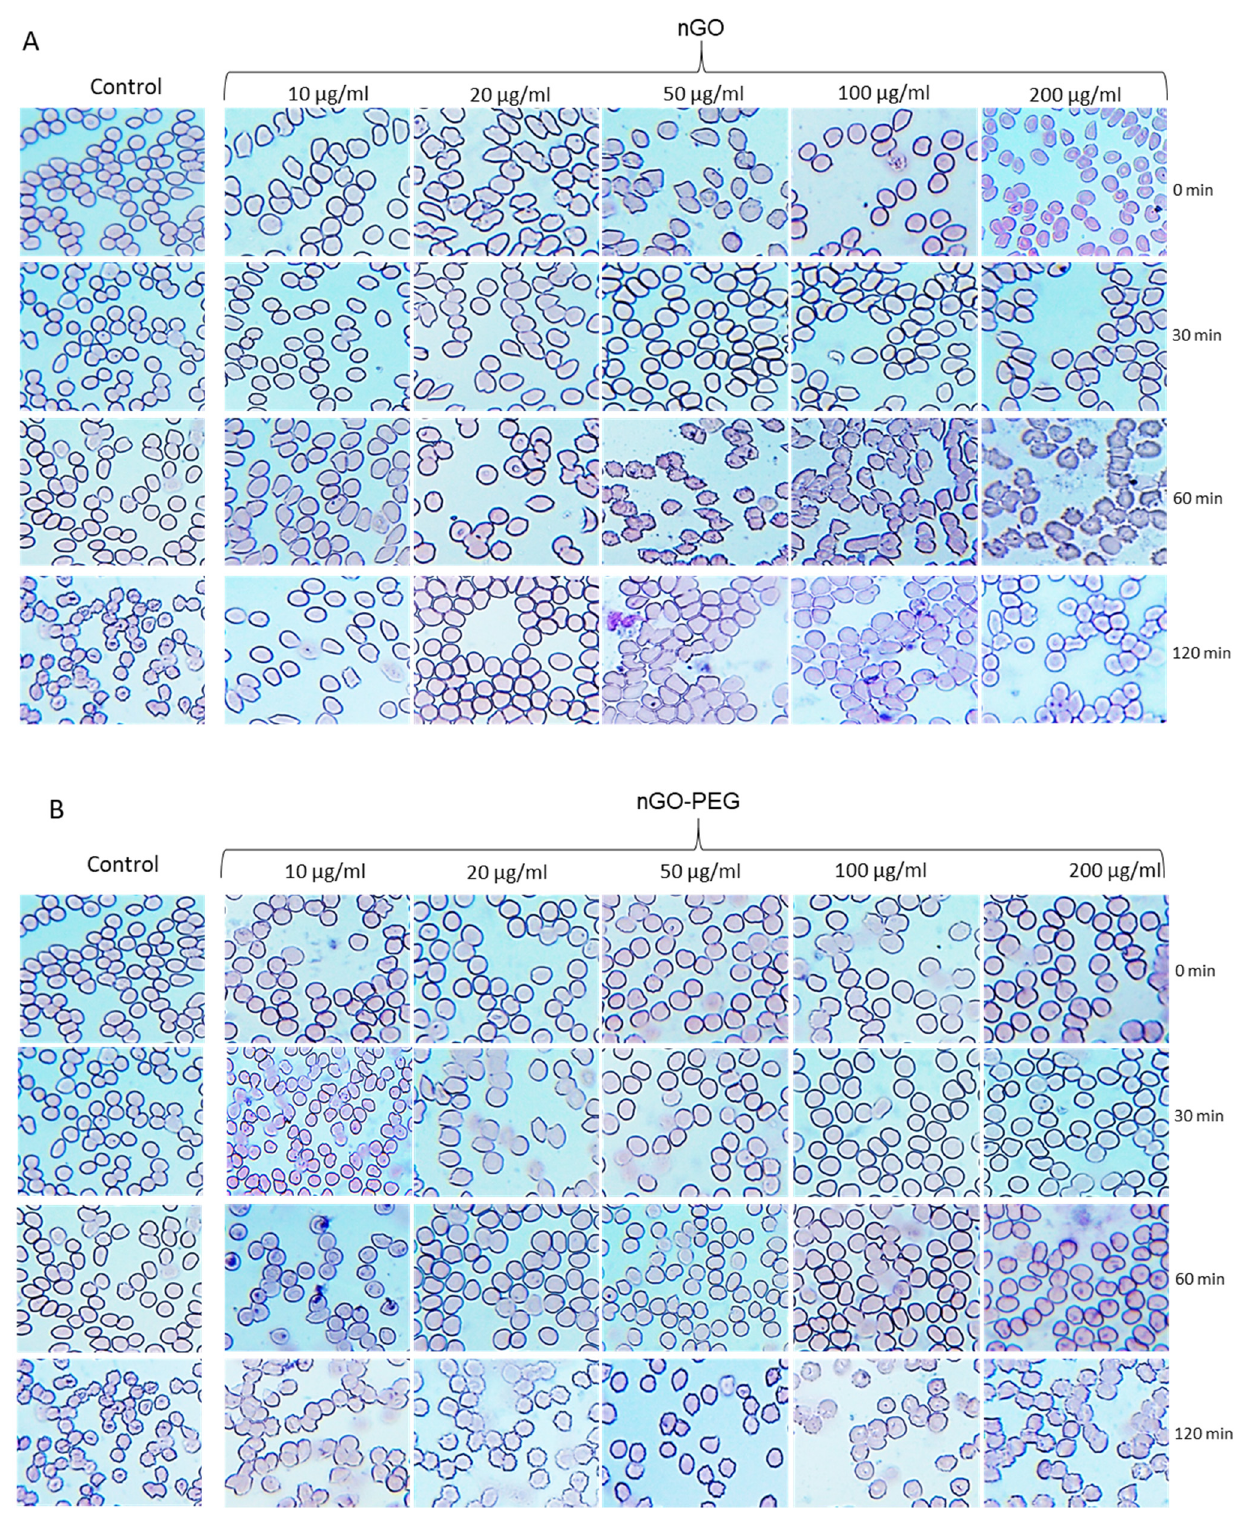
Figure 3. Effects of nGO and nGO-PEG NPs on erythrocyte morphology of RBCs after being treated by different concentrations (0, 10, 20, 50, 100 and 200 μ g/mL) of nGO ( A ) and nGO-PEG NPs ( B ) for different periods (0, 30, 60 and 120 min).